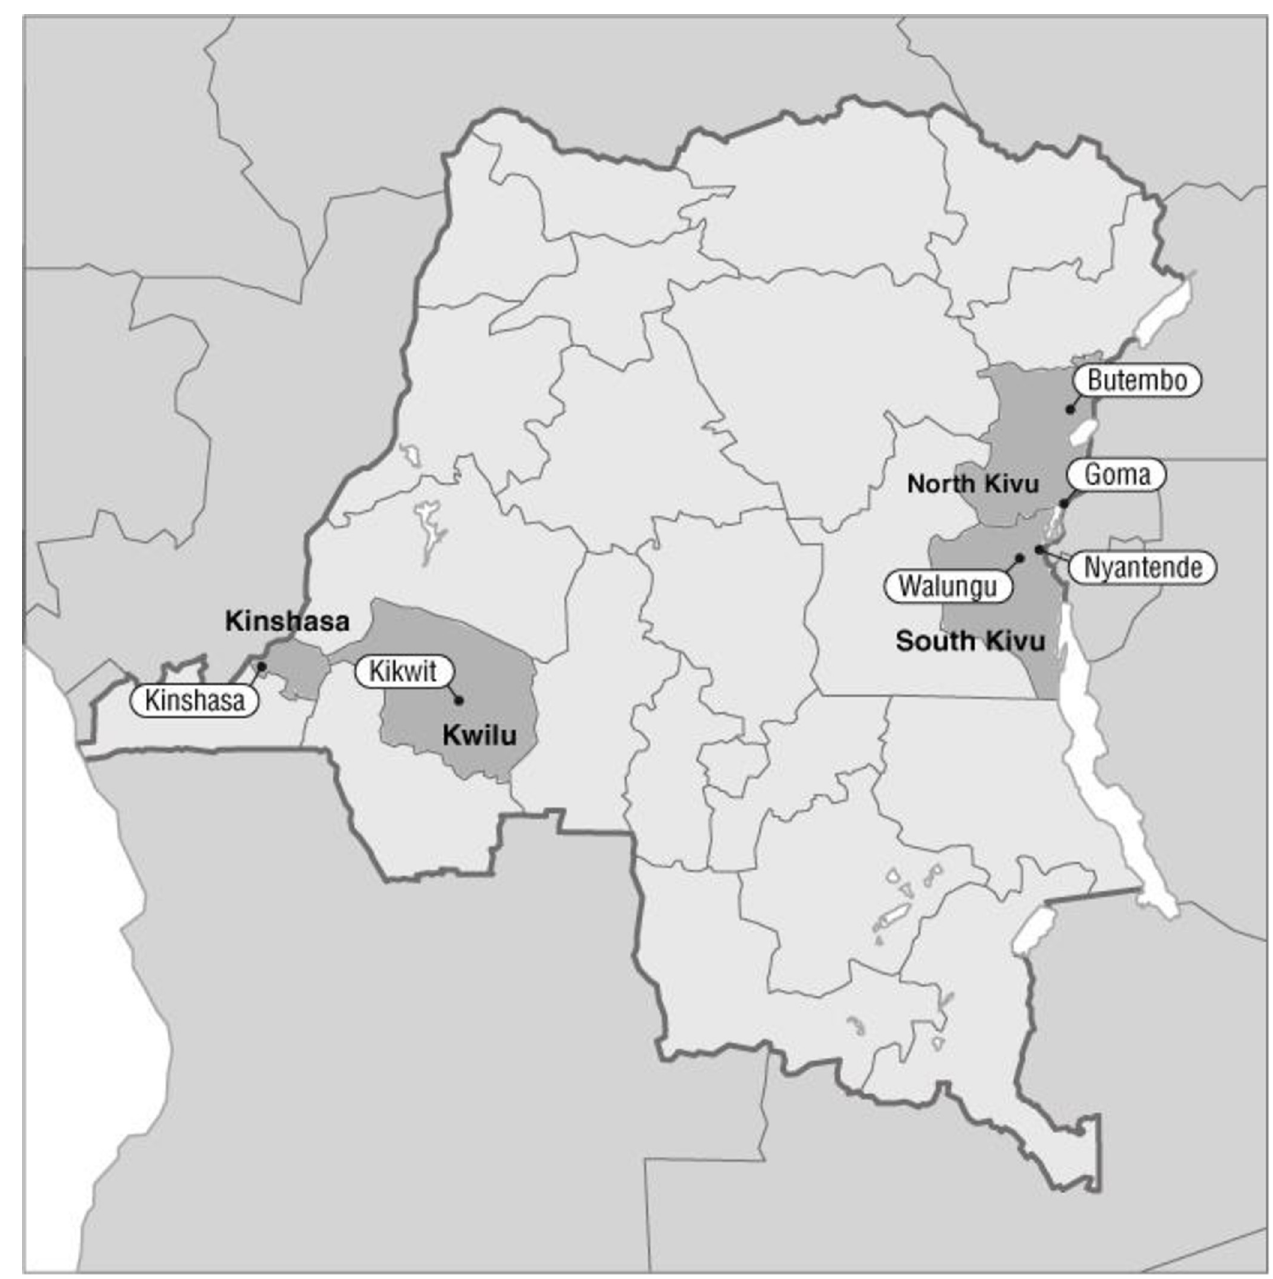
Fig 2. Provinces and locations of